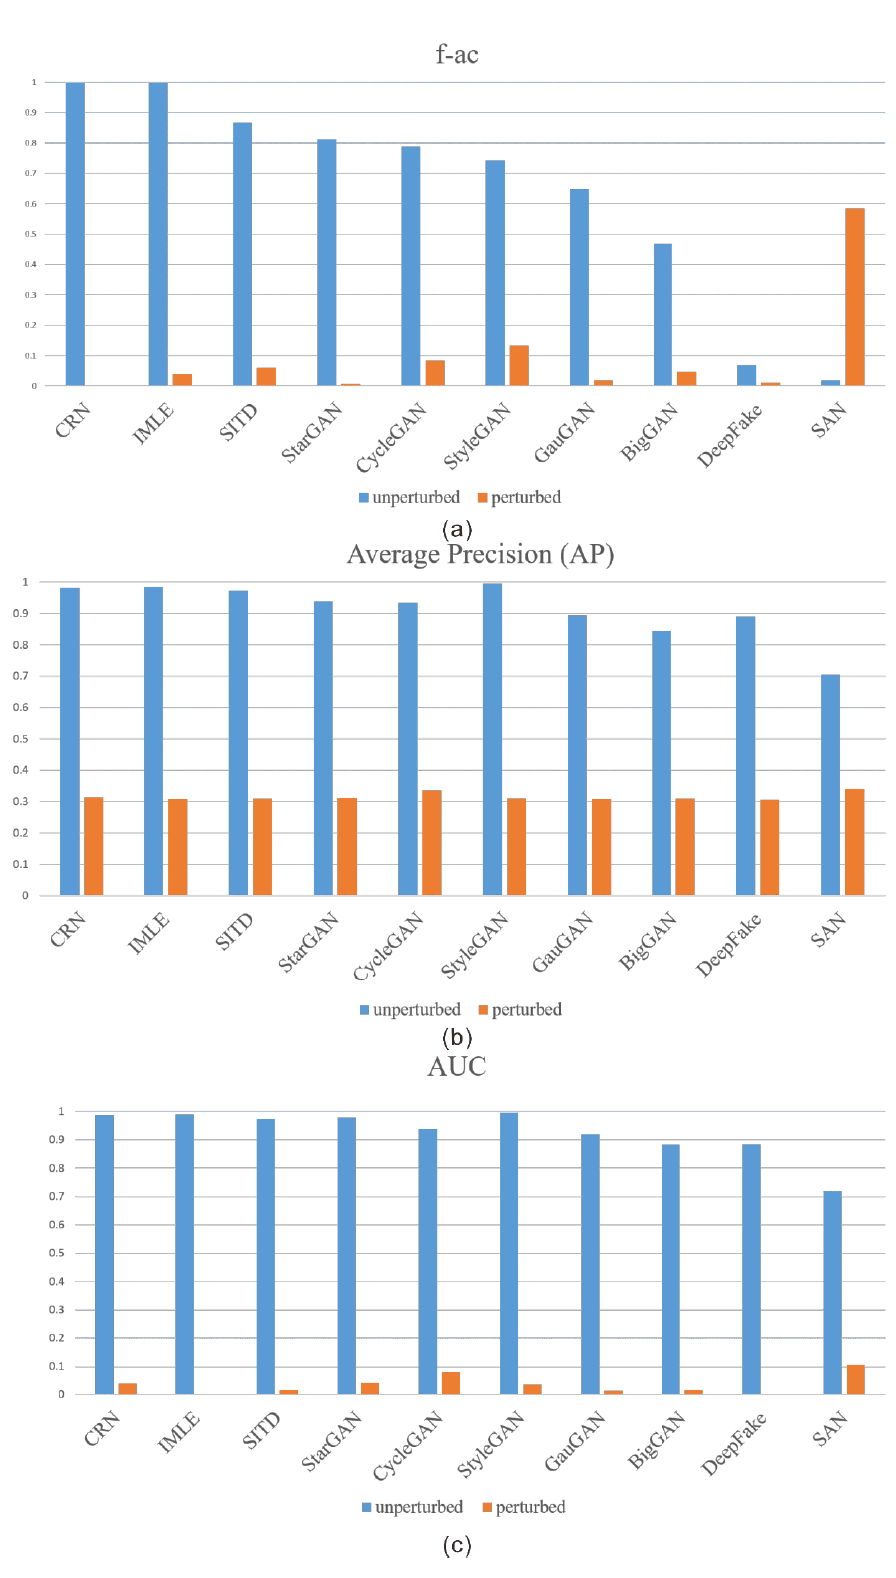
Figure 5. Comparison of histograms of f-ac ( a ), AP ( b ), and AUC ( c ) for the other ten generator models before and after adding perturbation. The blue histogram represents the indicator value before adding perturbations, and the orange histogram represents the indicator value after adding